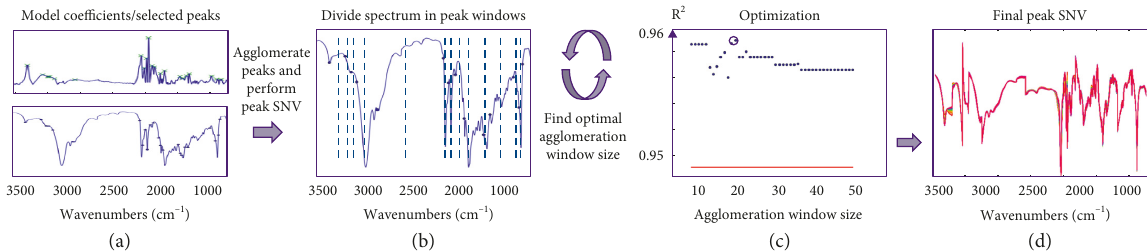
Figure 6: Demonstration of the workflow and optimization process for Dynamic Localized SNV. (a) Picked peaks of normalized absolute coefficient vector and indication of the POIs in one spectrum, (b) spectrum separation according to agglomerated peaks, (c) optimization process in order to find optimal agglomeration window size, and (d) optimized